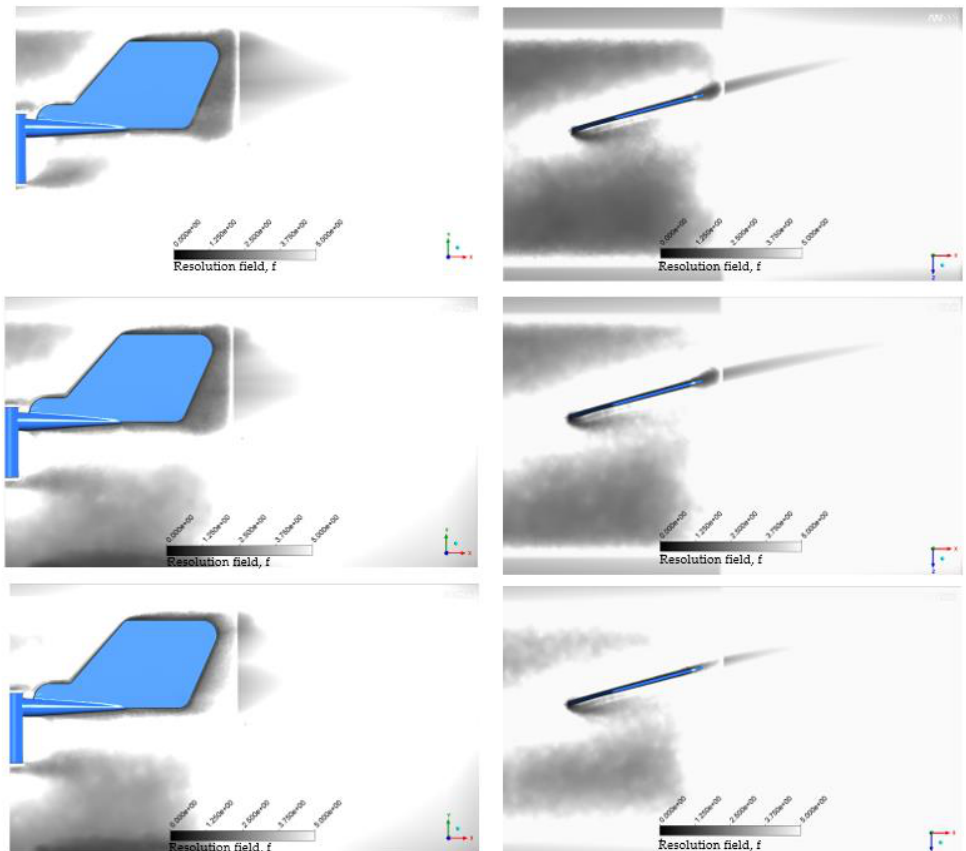
Figure 4. Consistent mesh refinement for obtaining acceptable resolution in the separation region (angle of attack = 15°). The scale is displayed in the vane plane and in the ZX plane at middle-line of tail.